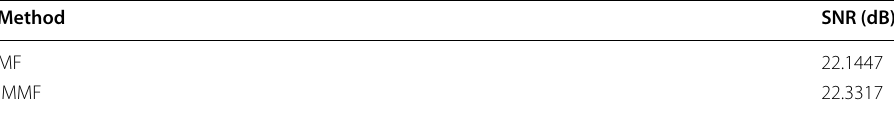
Table 3 Comparison of SNR of geomagnetic measurement signals after the second